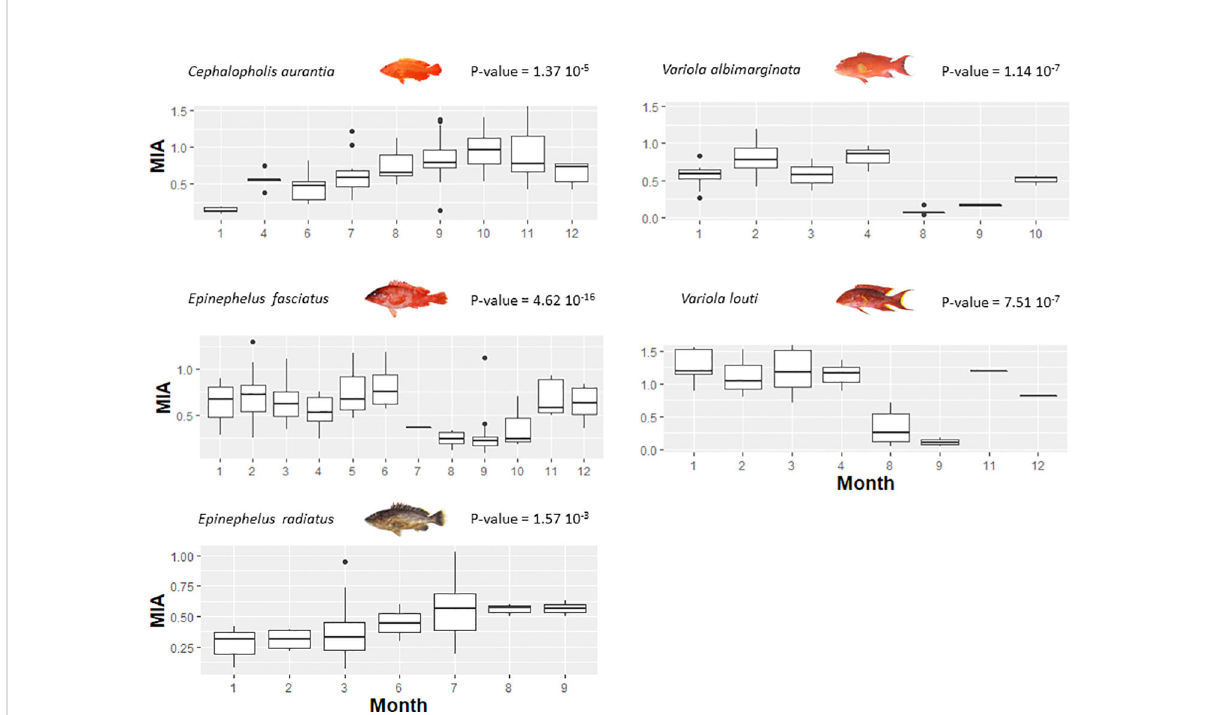
FIGURE 2 Periodicity validation of growth rings from Marginal Increment Analysis (MIA) of grouper species around La Re ́ union Island. Under the hypothesis of annual growth rings, an intra-annual periodicity of marginal increment growth is measured by the sinusoidal regression (signi fi cant if P-value ≤